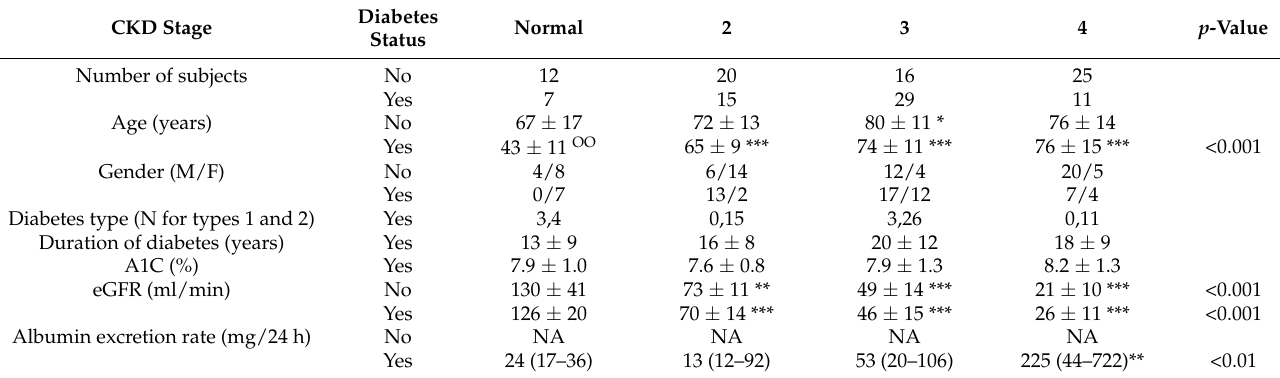
Table 1. Clinical characteristics of study